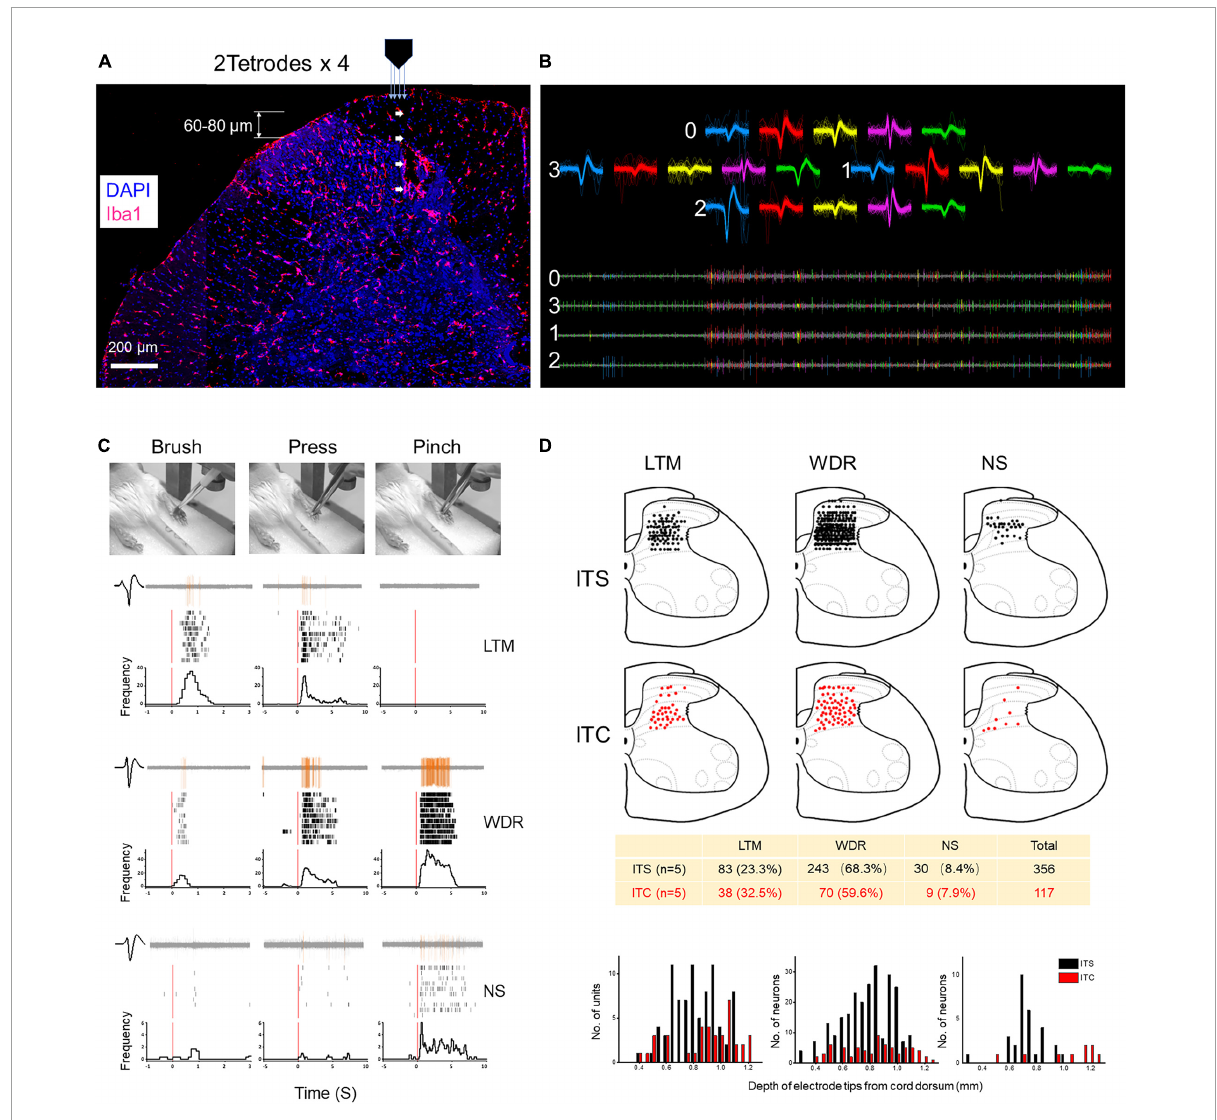
FIGURE2 Extracellular MEA mapping of spinal dorsal horn neurons 7 days after ITS or ITC. (A) Photomicrograph showing tetrode track and MEA recording sites at the spinal dorsal horn labeled with Iba1 and DAPI. (B) Waveforms and spike traces of five units sorted out by one tetrode (0–3). (C) Identification of three classes of dorsal horn neurons (LTM, WDR, and NS) by electrophysiological properties to brush, pressure, and pinch stimuli applied to their corresponding peripheral receptive fields in one hind paw pad showing by peri-stimulus time histograms and raster displays. (D) Spatial localization and counts of three classes of units across the dorsal horn from the surface of the cord dorsum to the deep layers by 60- to 80- µ m step advance following ITS ( n = 5) and ITC ( n = 5),